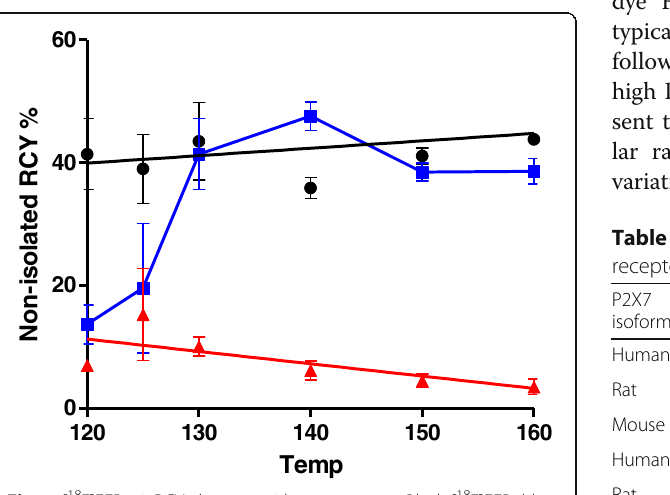
Fig. 5 [ 18 F]EFB n.i. RCY changes with temperature. Black , [ 18 F]EFB; blue , unknown by-product; red , unreacted [ 18 F]3